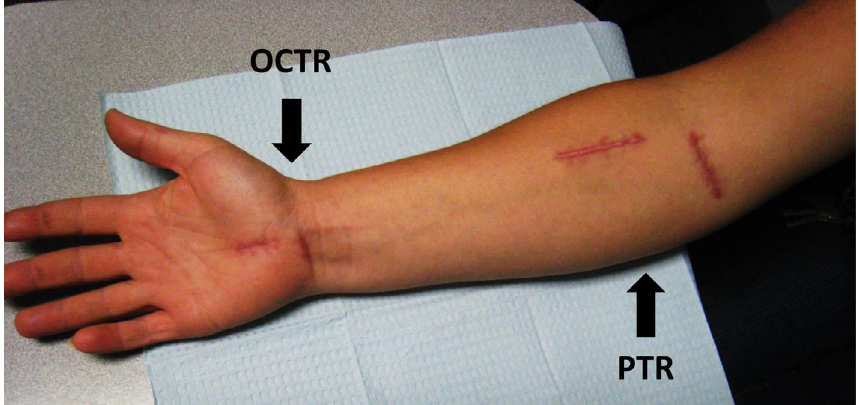
Figure 1. Incisions for pronator teres release (PTR) and opened carpal tunnel release